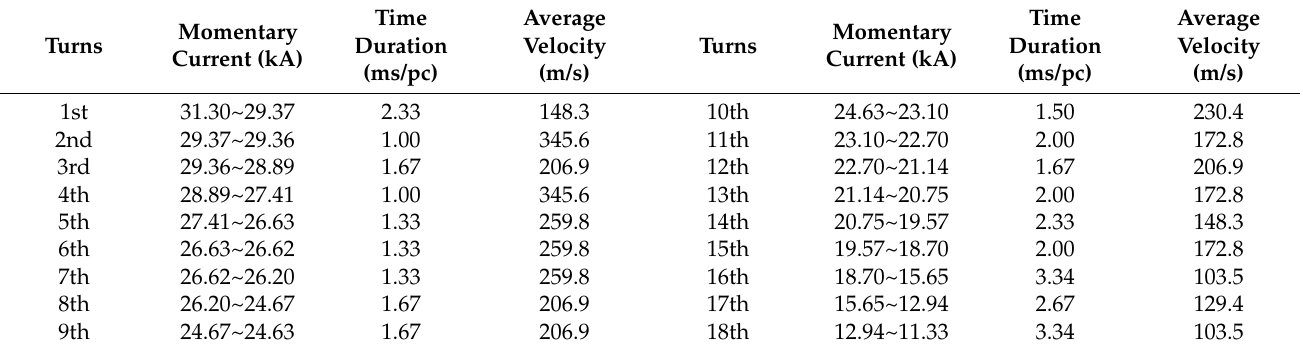
Table 4. Estimation of the averaged arc rotation velocity during the arcing process from experiment.